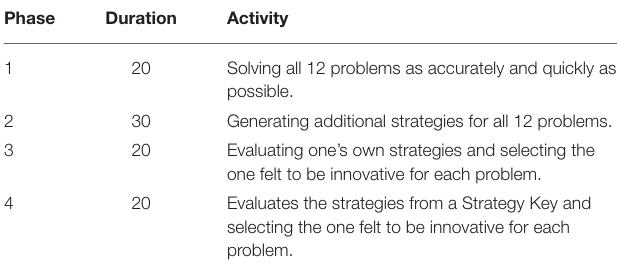
TABLE 2 | Overview of Procedure (time unit: